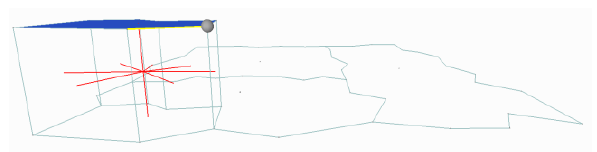
Fig. 10. Example of Normal Extrusion technique